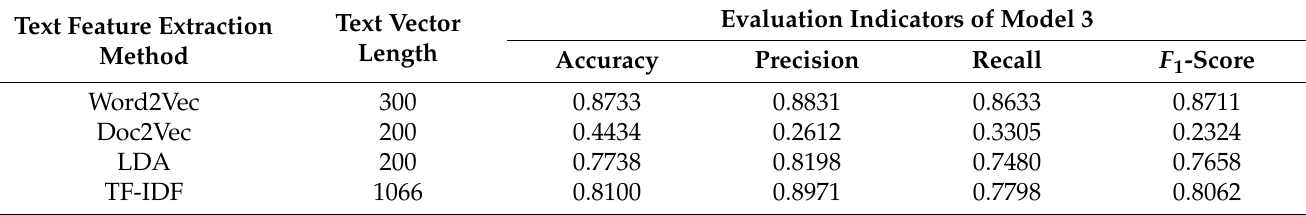
Table 8. Comparison of effect of troubleshooting mode selection method based on different text feature extraction methods.